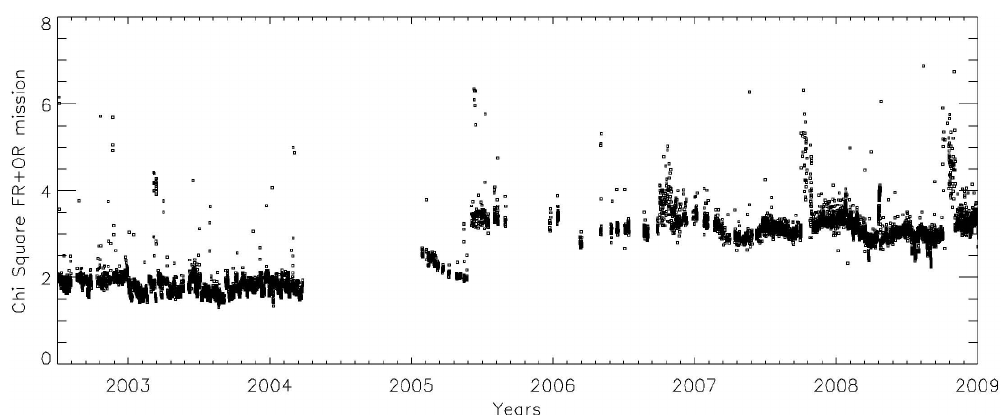
Fig. 9. χ 2 values of the MTR retrievals for the GRD dataset plotted as a function of acquisition